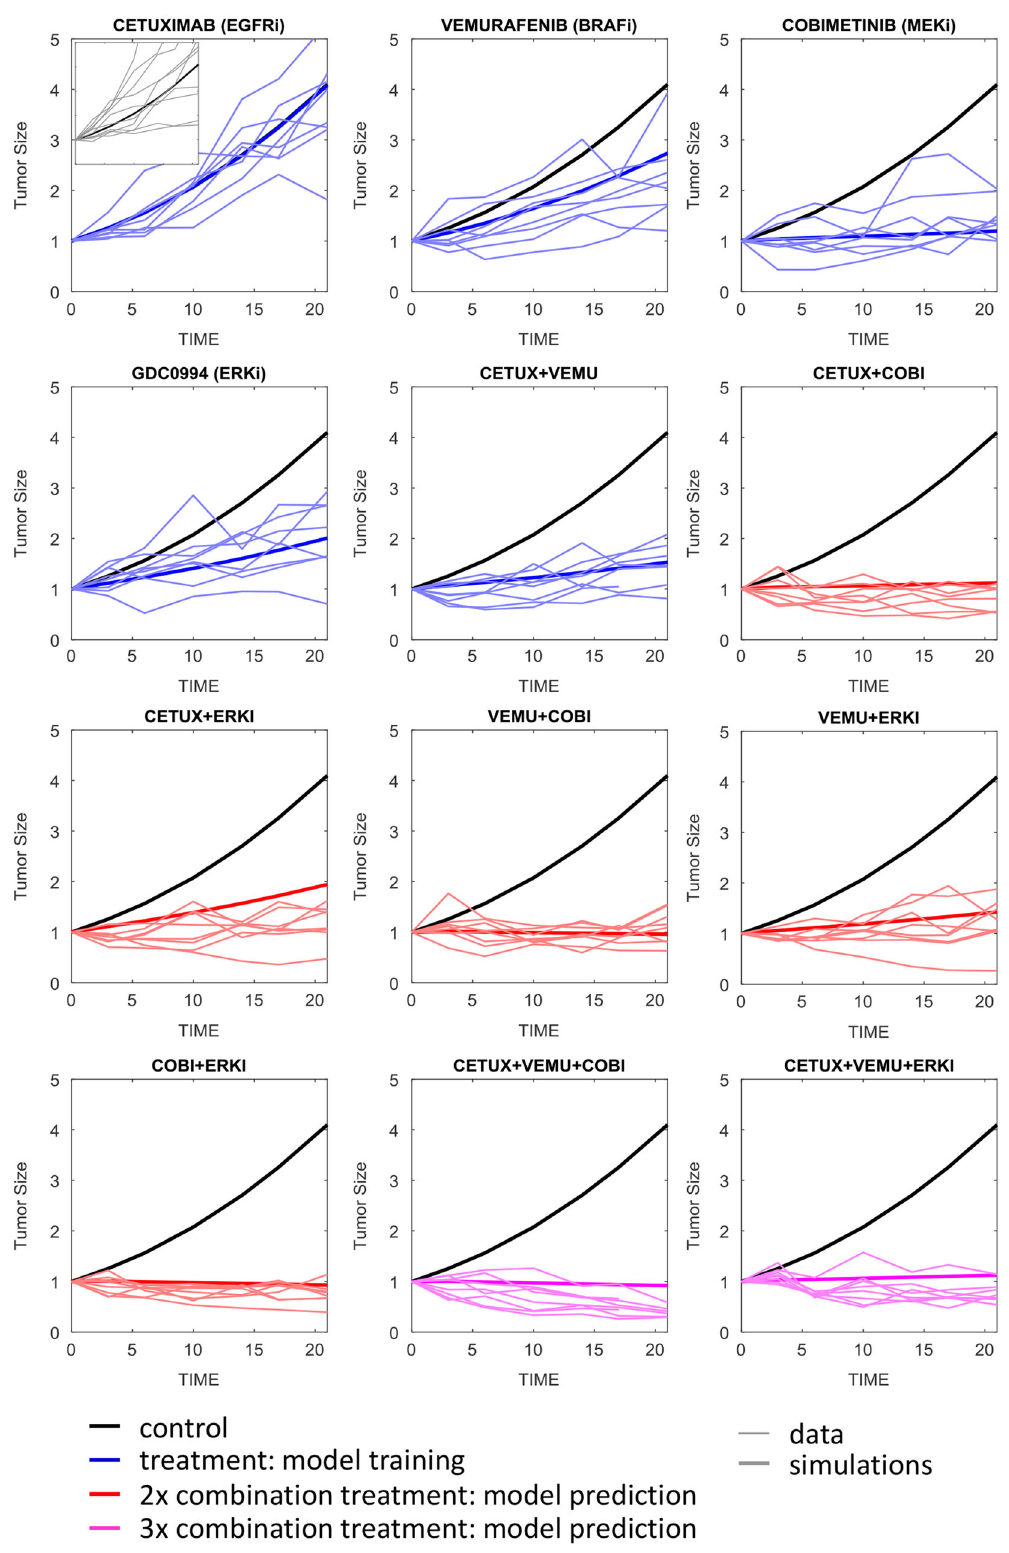
Fig. 4 HT29 xenograft tumor growth kinetics over 21 days. Individual tumors ( thin lines ) and model simulations ( thick lines ) overlaid, with plots color-coded as: untreated control ( black ), treatment data used for model training ( blue ), and model predictions, i.e., data not used for training ( red and pink , corresponding to double and triple drug